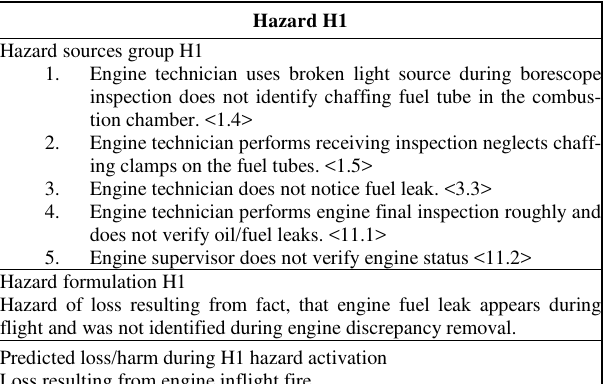
Table 2. Final results of the selected hazards specification process generat- ed in analysis domain 2, within process 1.3 (major engine objects